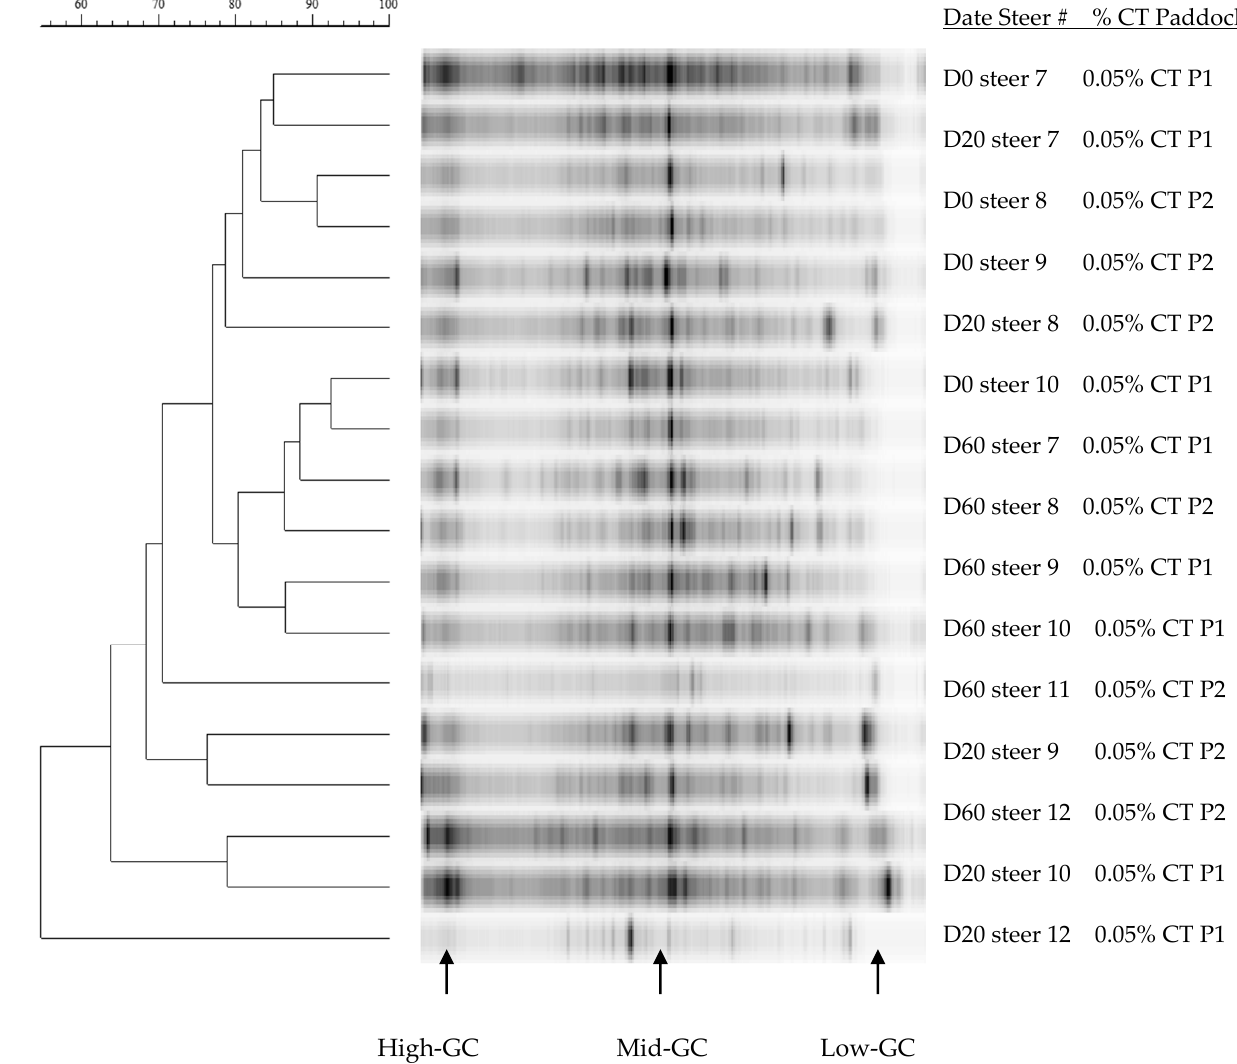
Figure 3. Dendrograms of denaturing gradient gel electrophoresis gels (DGGE) of rumen bacteria 16S rDNA amplicon bands patterns in steers ( n = 6) given winter wheat forage for day 0, day 20, and day 60 and containing 0.05% condensed tannins (CT; %/kg BW). P1 to P2 = each paddock (P). The bar above the figure indicates Dice percentage similarity coefficients (% SC). D = day, GC= guanines and cytosines, and Steer # = tag number (#).